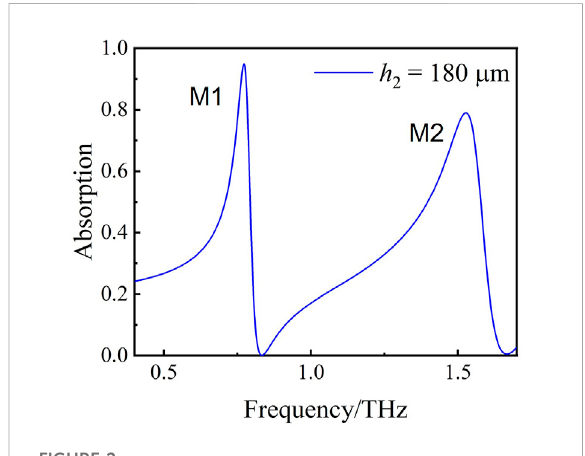
FIGURE 2 A Absorption spectrum of graphene-based THz metasurface sensor at h 2 (cid:1) 180 μ